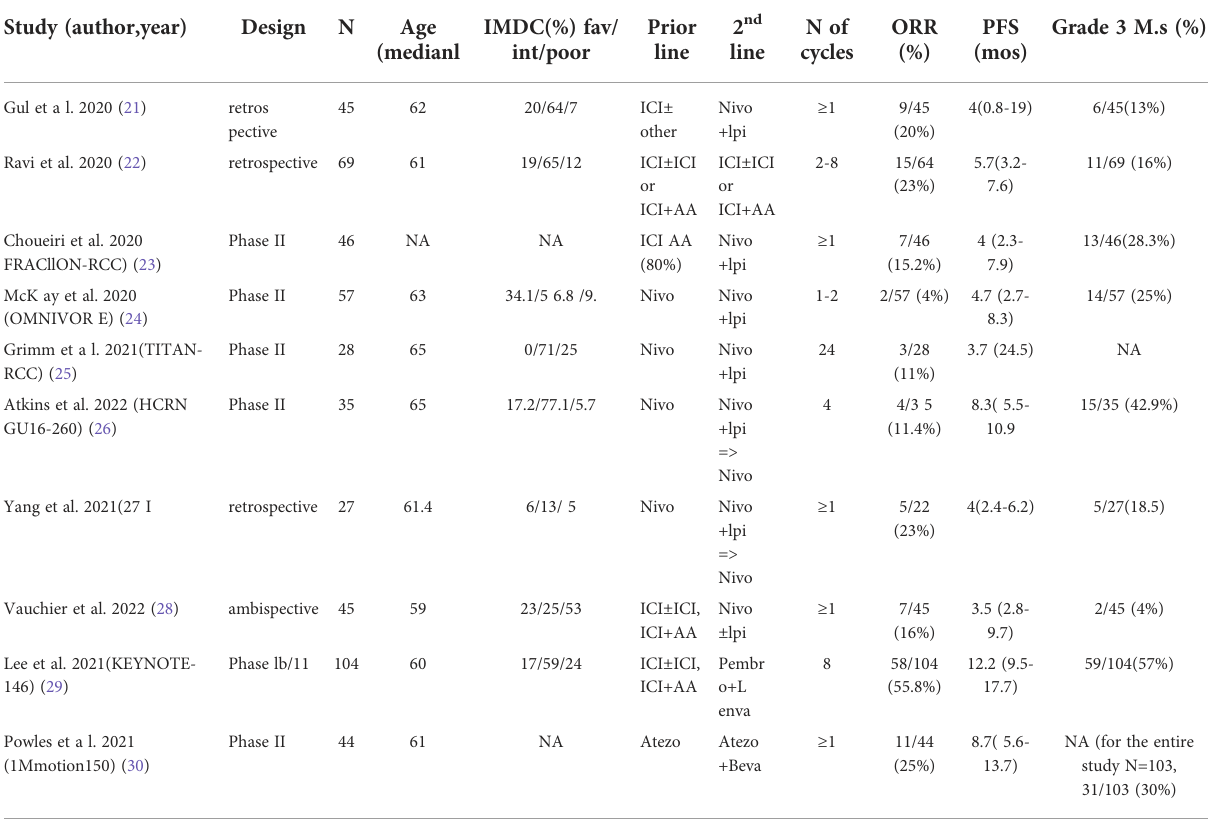
TABLE 1 Characteristics of included